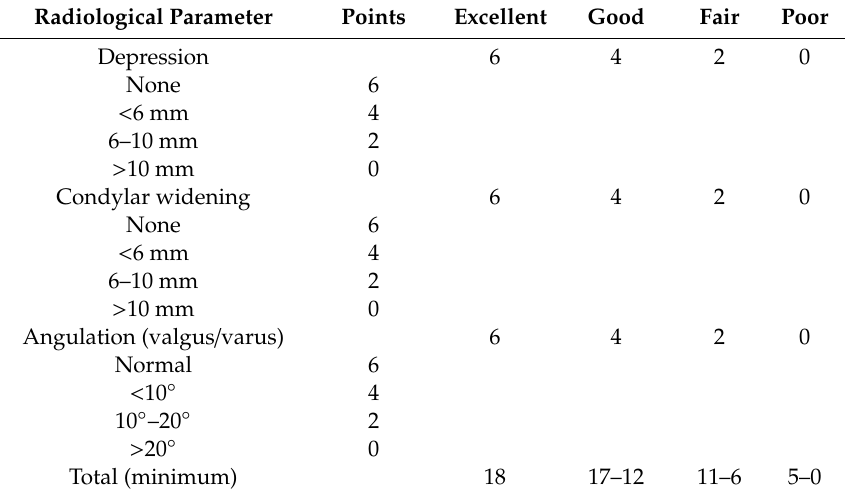
Table 3. Criteria for radiologic